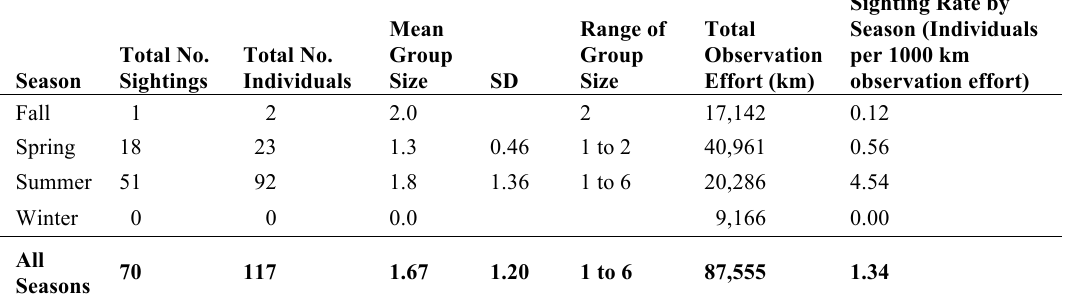
Summary of Blue Whale Sightings 1 , Individuals, Total Observation Effort (km) and Sighting Rates by Season